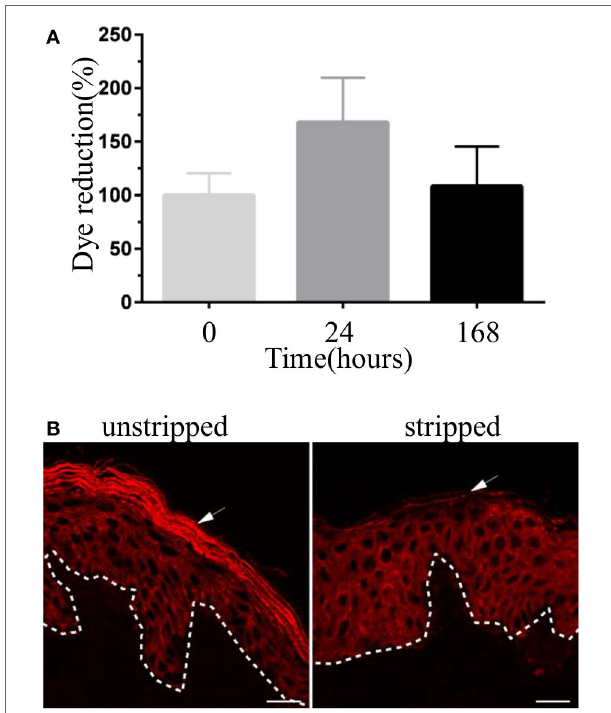
FigUre 1 | Validation of human skin explant model. (a) The viability of human skin explant in culture. Each bar represents the reduction of PrestoBlue dye staining (a cell viability testing reagent) by skin samples at different time points in culture compared with freshly received skin tissue (time 0). Results are pooled from three independent experiments. (B) Immunofluorescence images showing skin cryosections of unstripped and stripped human skin tissue stained with anti-pan-cytokeratin antibody. Stripped skin lacks stratum corneum (arrow). Scale bar: 20